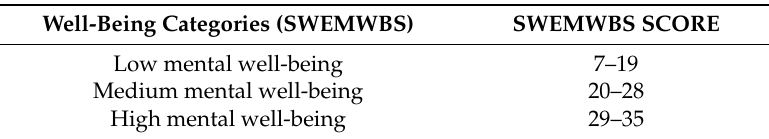
Table 2. Well-being category scoring